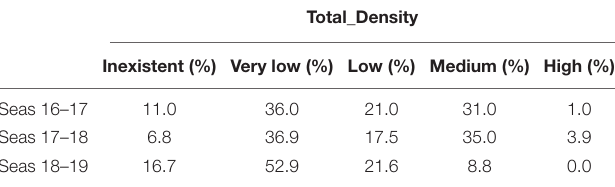
TABLE 9 | Contingency table: Season * Total player